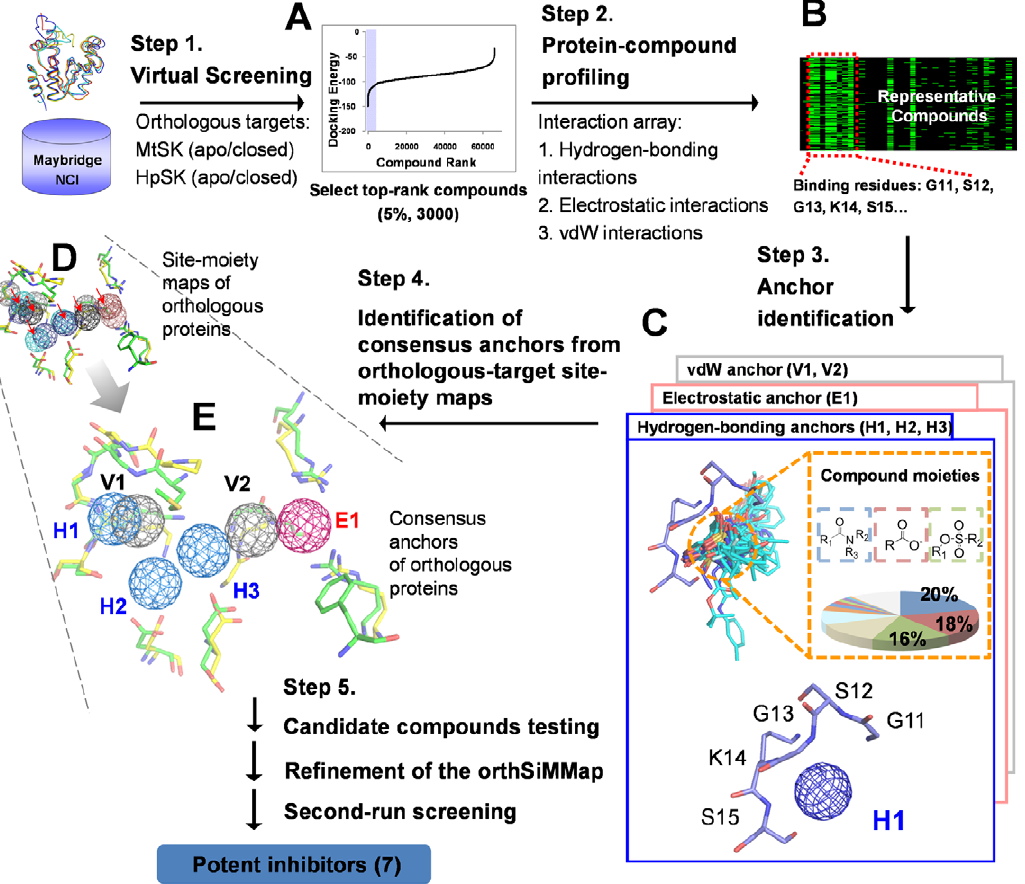
Figure 1. Framework of CoreSiMMap-based screening method. In Step 1, GEMDOCK was used to generate docked poses for HpSK and MtSK by screening compound libraries (Maybridge and NCI). For each target (HpSK or MtSK), the protein-compound interacting profile was derived by the top 2% ( , 6,000) of compounds ranked by docking energy. In Step 3, conserved interactions of the target protein and chemical moieties of ligands are identified to deduce the anchors of HpSK and MtSK. The CoreSiMMap is constructed based on the features that are conserved between orthologous target site-moiety maps, which will be used to select candidate compounds for the enzymatic assay. Finally, the model is refined based on the bioassay of candidate compounds.